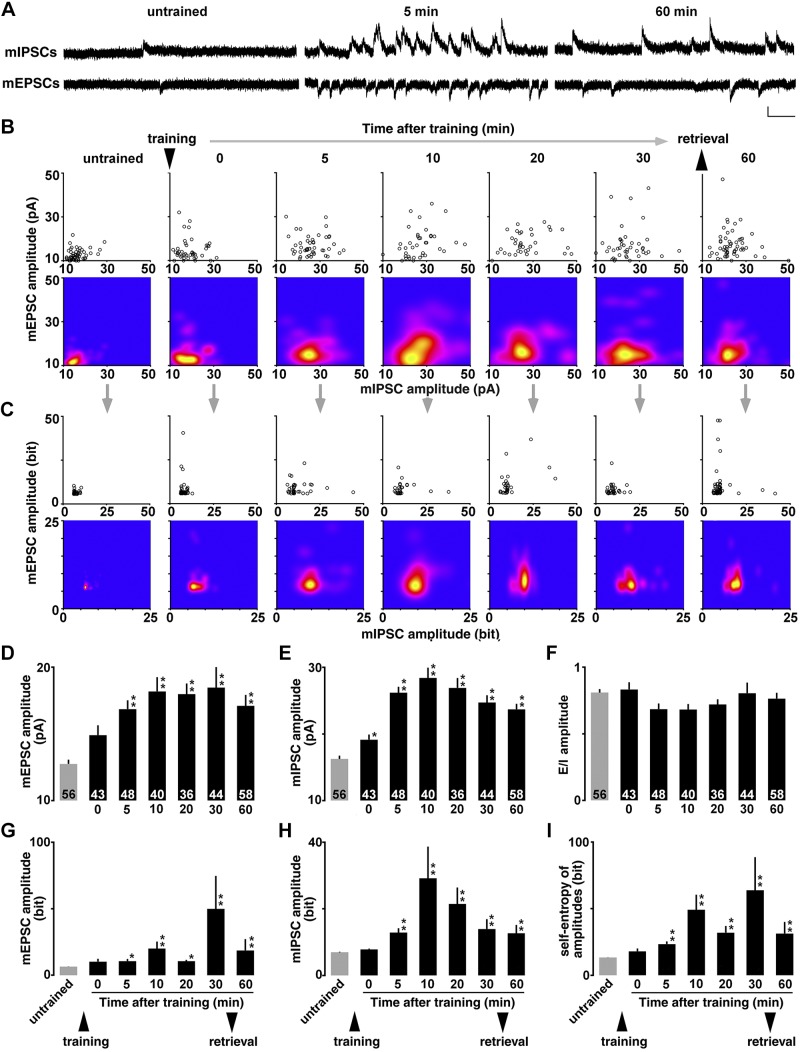
Temporal dynamics of the learning-induced diversity of mEPSC and mIPSC amplitudes and entropy analysis. A) Representative traces of mEPSCs and mIPSCs. We measured the mEPSCs at −60 mV and mIPSCs at 0 mV sequentially in the same CA1 pyramidal neuron in the presence of tetrodotoxin (0.5 µM). Vertical bar = 20 pA; horizontal bar = 50 ms. B) Plots of the means mEPSC and mIPSC amplitudes in each neuron (upper) and the visualized density by kernel analysis (lower). C) By calculating appearance probability of each dot, we plotted self-entropy (bit) of individual neurons (upper) and visualized the density by kernel analysis in untrained and trained rats (lower). D, E) Mean amplitude of mEPSCs (D) or mIPSCs (E) in all recorded neurons in untrained and trained rats. IA training increased mEPSC amplitude within 5 min, whereas it increased mIPSC amplitude within 1 min after the training (0 min). F) E/I balance of the mEPSC and mIPSC amplitude did not change after the training. G, H) The training also increased the self-entropy (bit) of excitatory (G) and inhibitory (H) synapses in CA1 neurons. I) Combined self-entropy (bit) of the mEPSC and mIPSC amplitudes in untrained and trained rats. The number of cells in each group is shown at the bottom of each bar. Error bars indicate + sem. *P < 0.05, **P < 0.01 vs. untrained. ▼ or ▲ indicate the timing of training or retrieval tests.